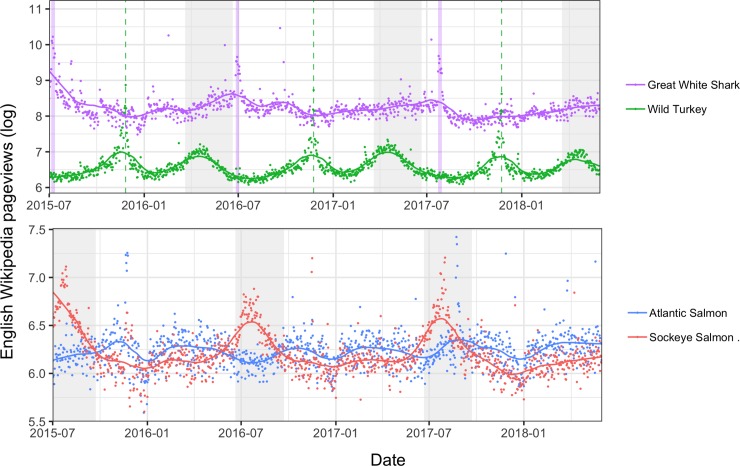
Effects of culture and phenology on the seasonality of interest in species.(Top panel) Patterns in Wikipedia pageviews respond to cultural influences as well as biological ones. English-language pageviews (logged) for great white shark Carcharodon carcharias (purple) are relatively stable throughout the year but show a brief spike during the days when “Shark Week” was aired on television by the Discovery Channel (days highlighted in purple). Pageviews for wild turkey Meleagris gallopavo (green) show a seasonal peak in the spring and a sharp peak during the Thanksgiving holiday in the US (date marked with a dashed line). The spring peak roughly coincides with the spring hunting season for wild turkey in many US states. (Bottom panel) The popularity of species relative to one another, as measured in Wikipedia pageviews, can vary as a result of seasonal fluctuations. Sockeye salmon Oncorhynchus nerka (red) and Atlantic salmon Salmo salar (blue) alternate in relative popularity depending on the time of year. Sockeye, which has a pronounced seasonal pattern, are more popular than Atlantic salmon in the Northern Hemisphere summer (dates shaded gray; for data used in plots, see S2 Data).